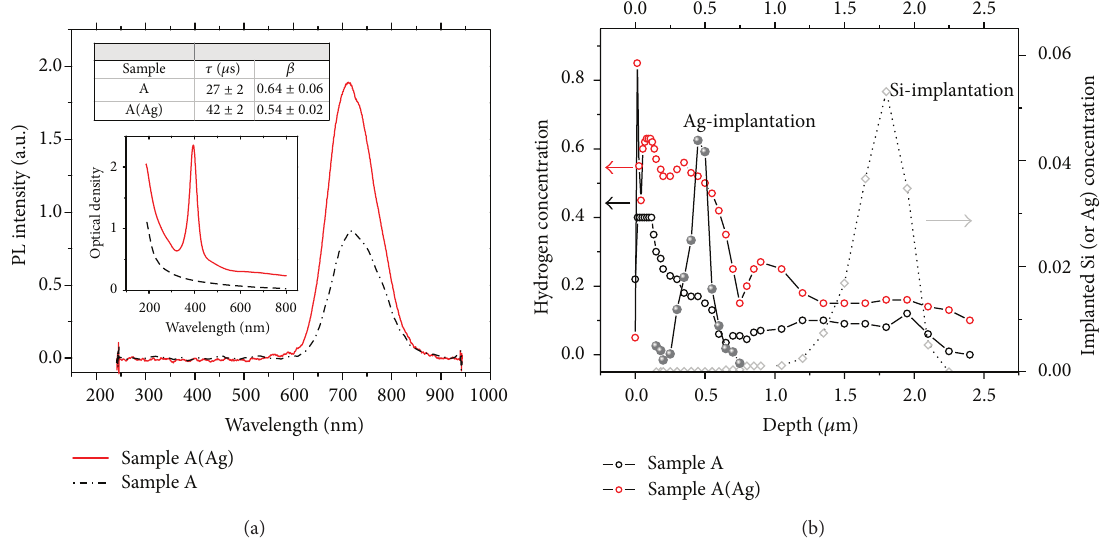
Figure 4: (a) PL emission from samples A (dashed black curve) and A (Ag) (red line). The inset graph shows the respective optical density. Inset table shows the parameters fitting of the measured PL decay curve of each sample according to the stretched exponential model mentioned above. (b) Hydrogen depth profile by ERD. Black triangles and red circles show the hydrogen concentration of samples A and A (Ag), respectively. Ag depth profile (filled gray circle) by RBS and Si depth profile (open gray rhomb) by SRIM simulation are shown for comparison.